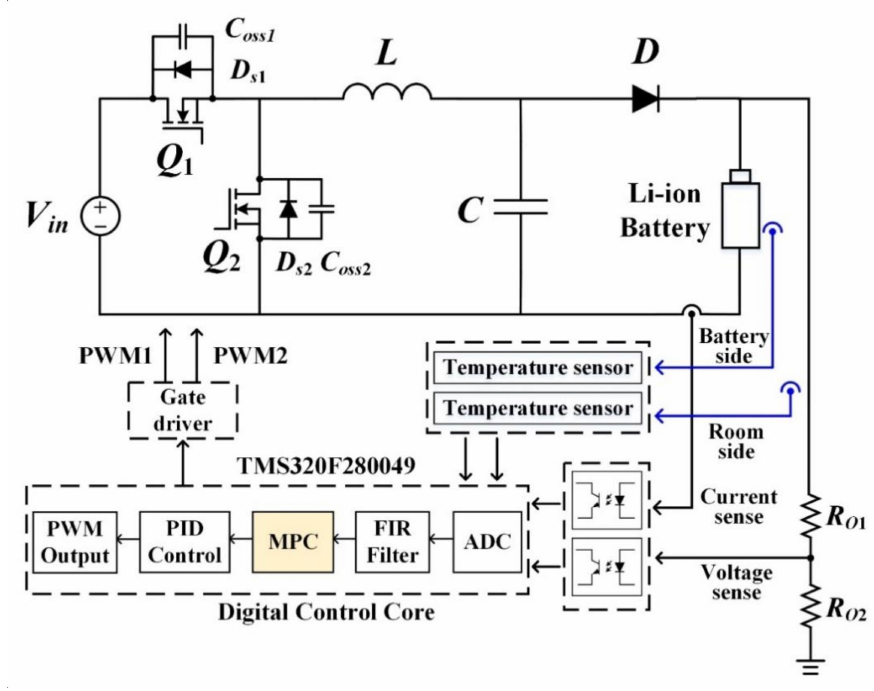
Figure 8. Block diagram of the proposed model predictive control (MPC) charger. Table 4. Specification of the utilized synchronous buck converter.